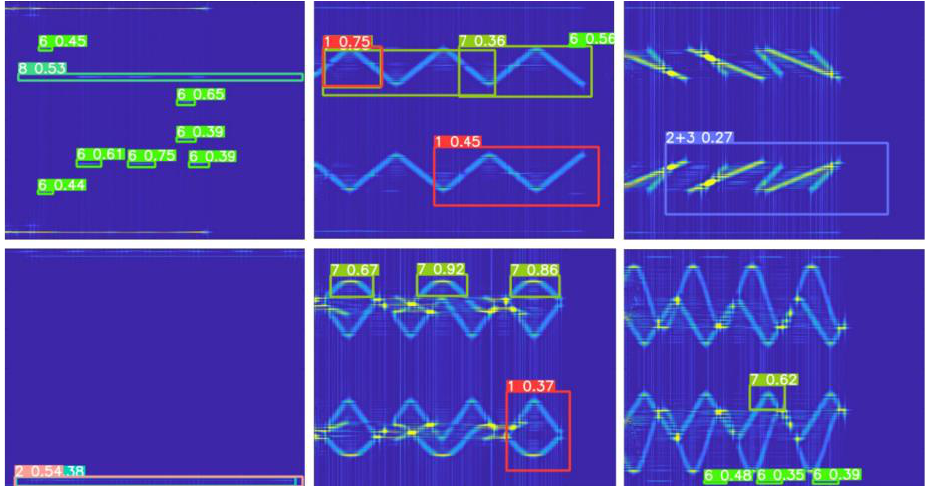
Figure 13. Identification results of the YOLOv5s model.